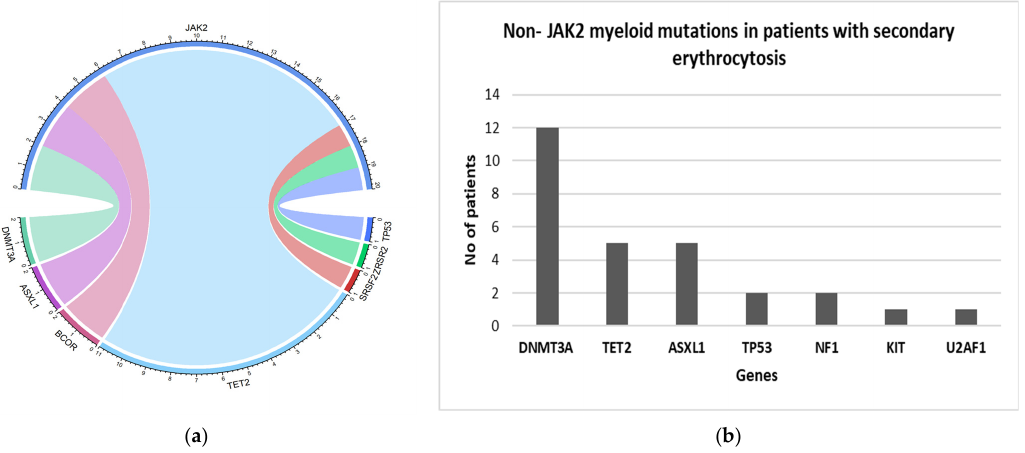
Figure 1. ( a ) Circos plots showing co-occurrence of additional mutation in JAK2 positive PV pa- tients; ( b ) Bar Graph showing myeloid mutations in JAK2 negative patients with secondary eryth- rocytosis.